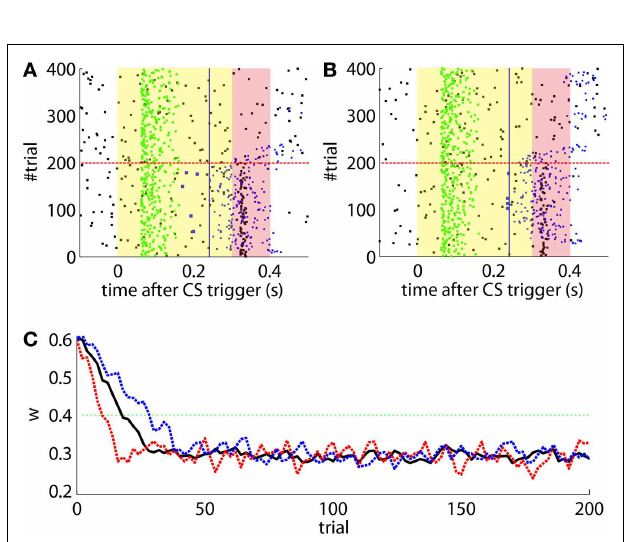
FIGURE 7 | Results with non-delayed NOI inhibition in different conditions. Raster plots with the output of the model with the delay of the NOI set to 0s. (B) the model constraint to acquire CRs twice as fast or with (A) . A ratio ofTDs in the IO lowered to 50%. (C) Traces of the synaptic efficacy w for the simulation in Figure 6 (black) compared to the simulations in (A) (dotted red) and (B) (dotted blue).